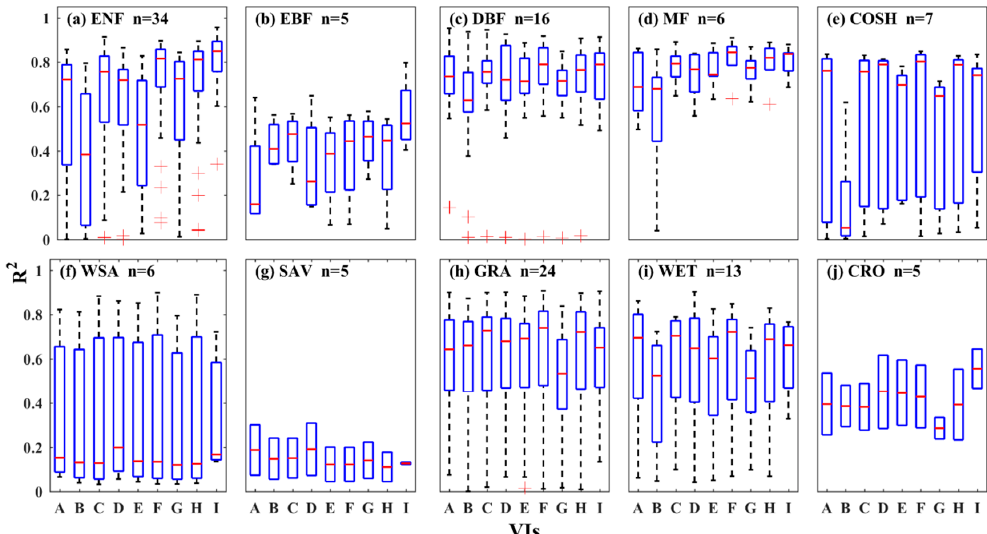
Figure 6. The boxplots of the R 2 values for the relationships of monthly averaged VIs and MODIS GPP with temperature stress (f Topt ) for each biome with the total of 121 sites. The letters on the x axis stand for: A - NDVI, B - EVI, C - EVI2, D - NDVI BRDF , E - EVI BRDF , F - EVI2 BRDF , G - NIR V , H - NIR V, BRDF , and I - MODIS GPP. The biome types are as follows: evergreen needleleaf forest (ENF); evergreen broadleaf forest (EBF); deciduous needleleaf forest (DNF); mixed forest (MF); closed and open shrublands (COSH); woody savannas (WSA); savannas (SAV); grasslands (GRA); wetlands (WET); croplands